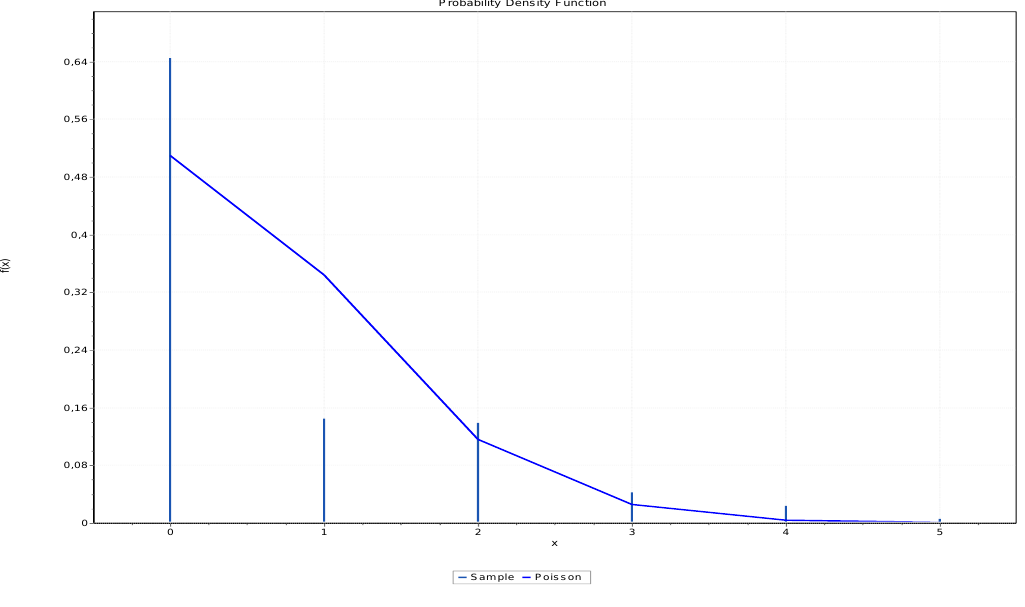
Figure 5. Poisson distribution of the input flow.